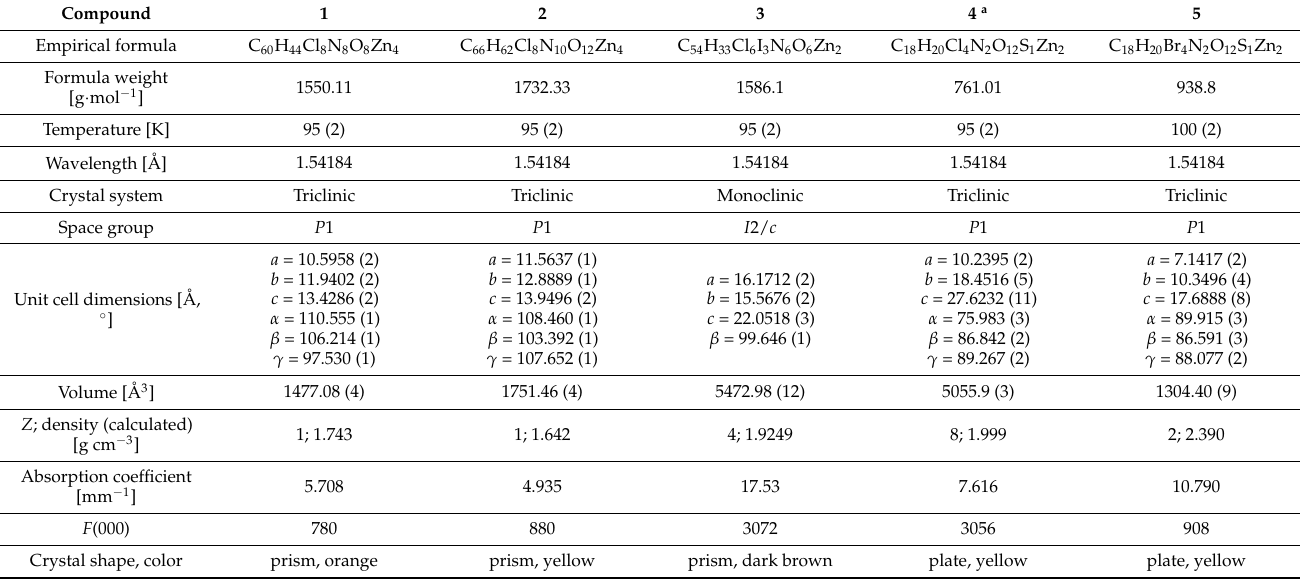
Table 11. Crystal data and structural refinement for 1 – 5